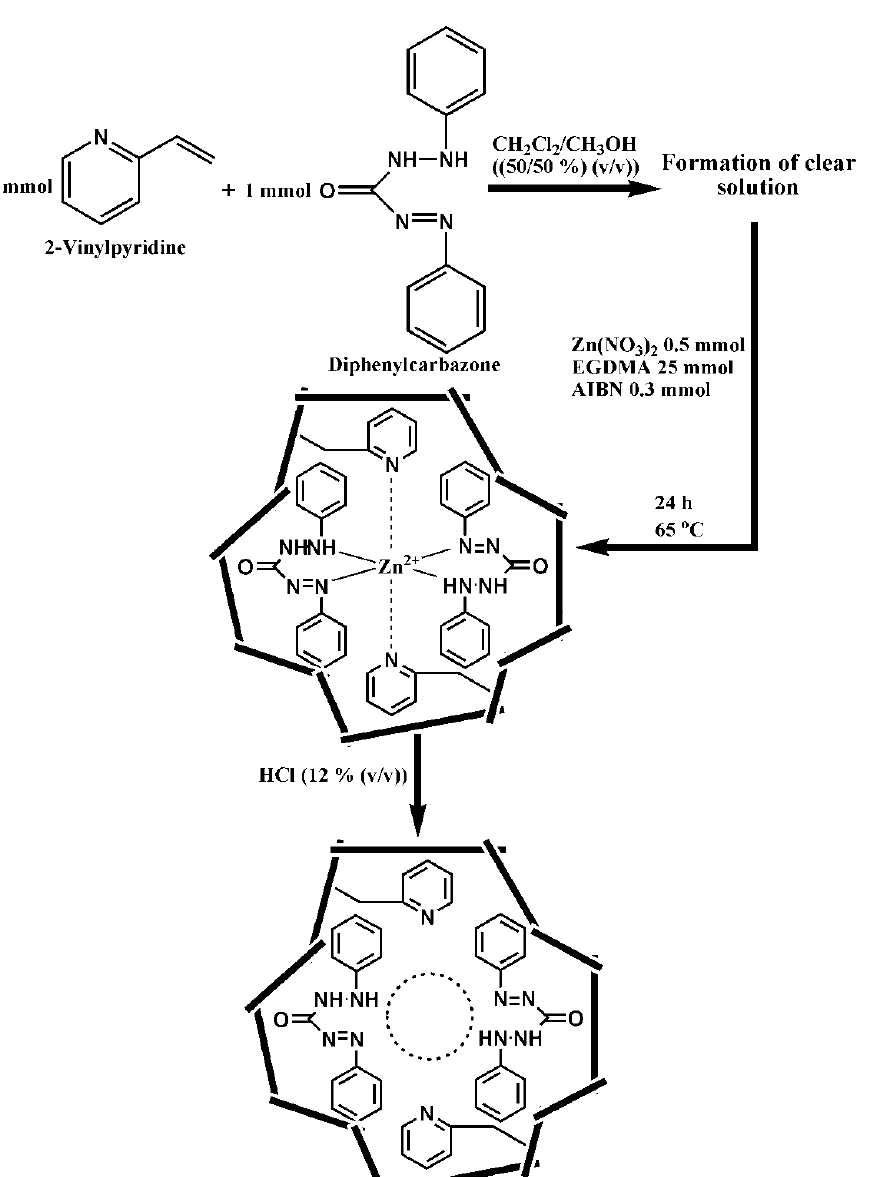
Figure 8. Schematic illustration of imprinting process for the preparation of Zn(II)-IP by bulk polymerization. (Adapted with permission from. Ref. [89]. Copyright 2014 Elsevier).